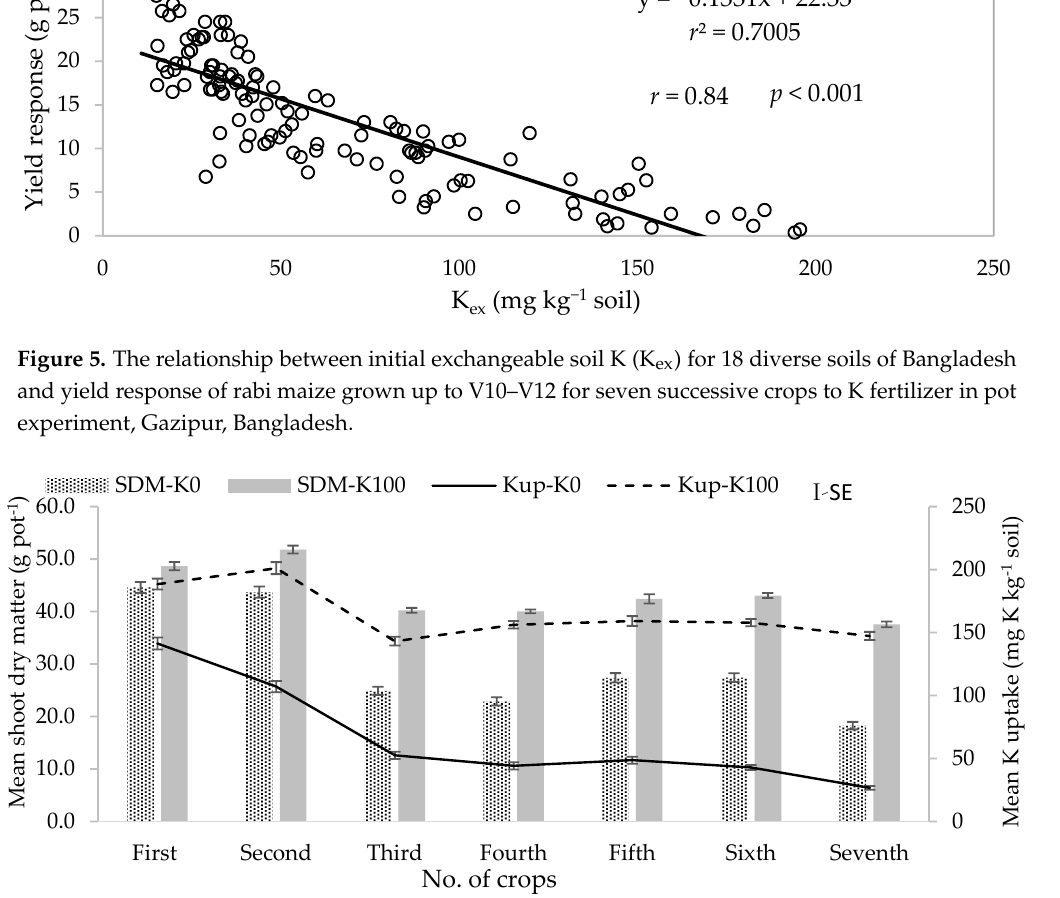
Figure 6. Trends for mean shoot dry matter (SDM) and mean K uptake over 18 diverse soils for seven successive cropping of rabi maize with K0 and K100 in pots in Gazipur, Bangladesh.